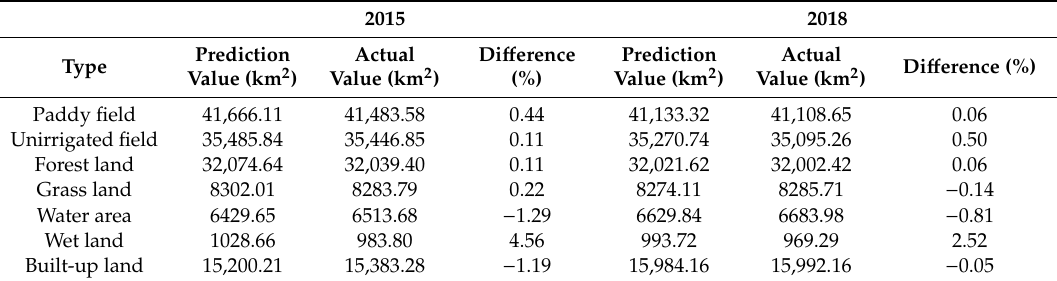
Table 7. Prediction results comparison of land use structure for 2015 and 2018.